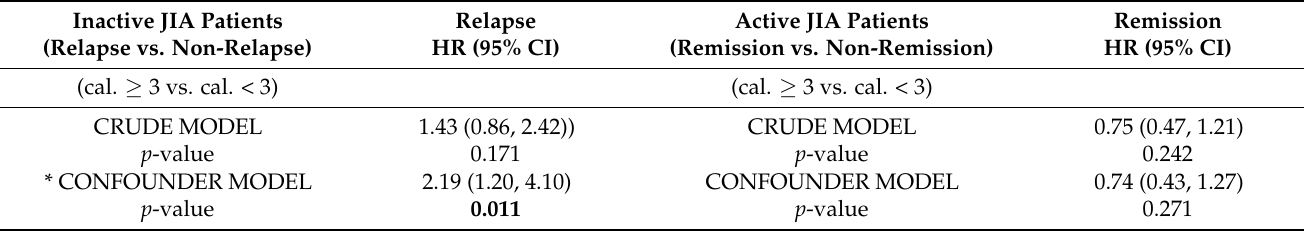
Table 2. Associations of different cut-off levels of serum calprotectin with the risk of relapse or remission in inactive and active JIA patients,